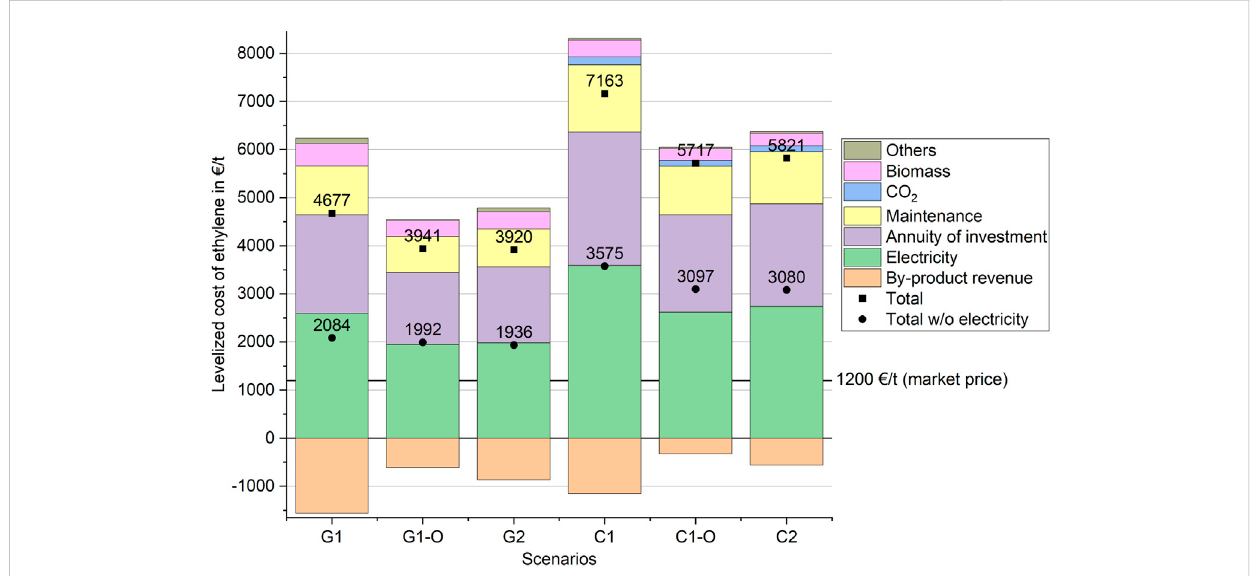
FIGURE 7 LCOE broken down into themain cost categories, thesquare dotrepresents thetotal LCOE and theround dot shows theLCOE leaving outthe cost for electricity (data available in Supplementary Material as